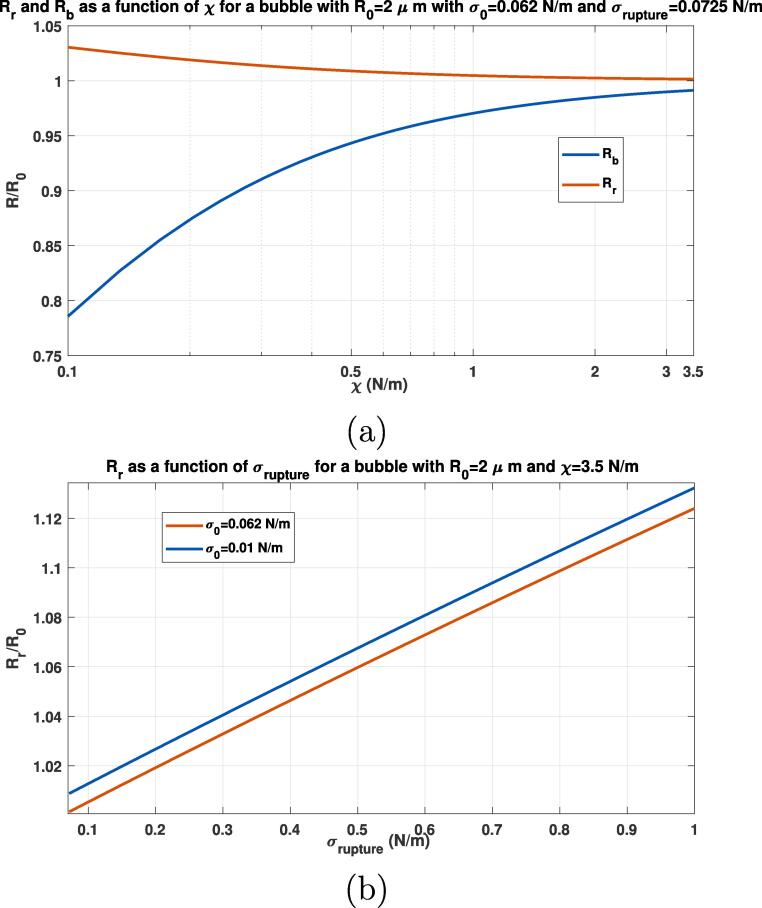
Case of a C3F8 lipid coated bubble with R0=2μm: a) variations of Rr and Rb as a function of χ when σ0=0.062N/m and σrupture=0.0725N/m, b) Variations of Rr as a function of σrupture when χ=3.5N/m and σ0=0.01N/m and 0.062N/m.